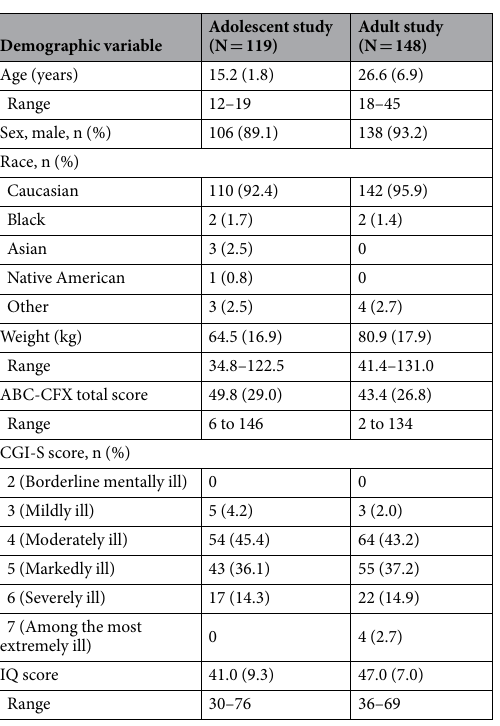
Table 1. Demographics and extension study baseline characteristics (full analysis set). Data are mean (standard deviation [SD]) unless indicated otherwise. ABC-C FX , Aberrant Behavior Checklist – Community edition